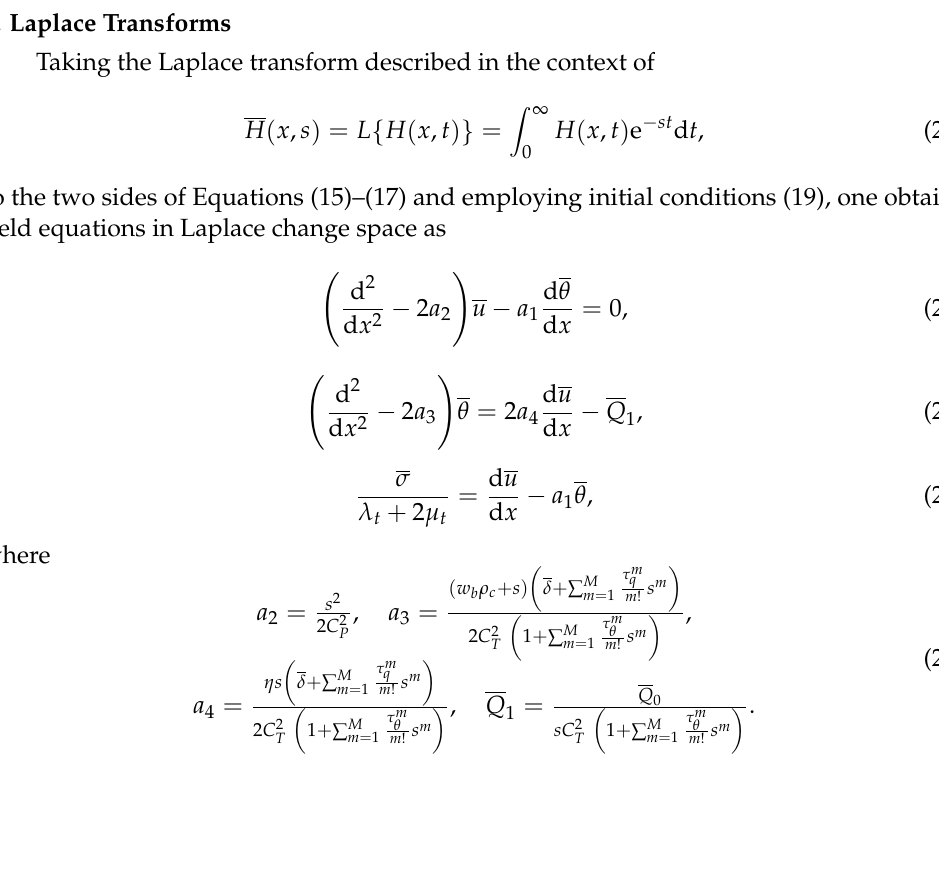
Figure 1. The skin tissue pattern with boundary conditions.